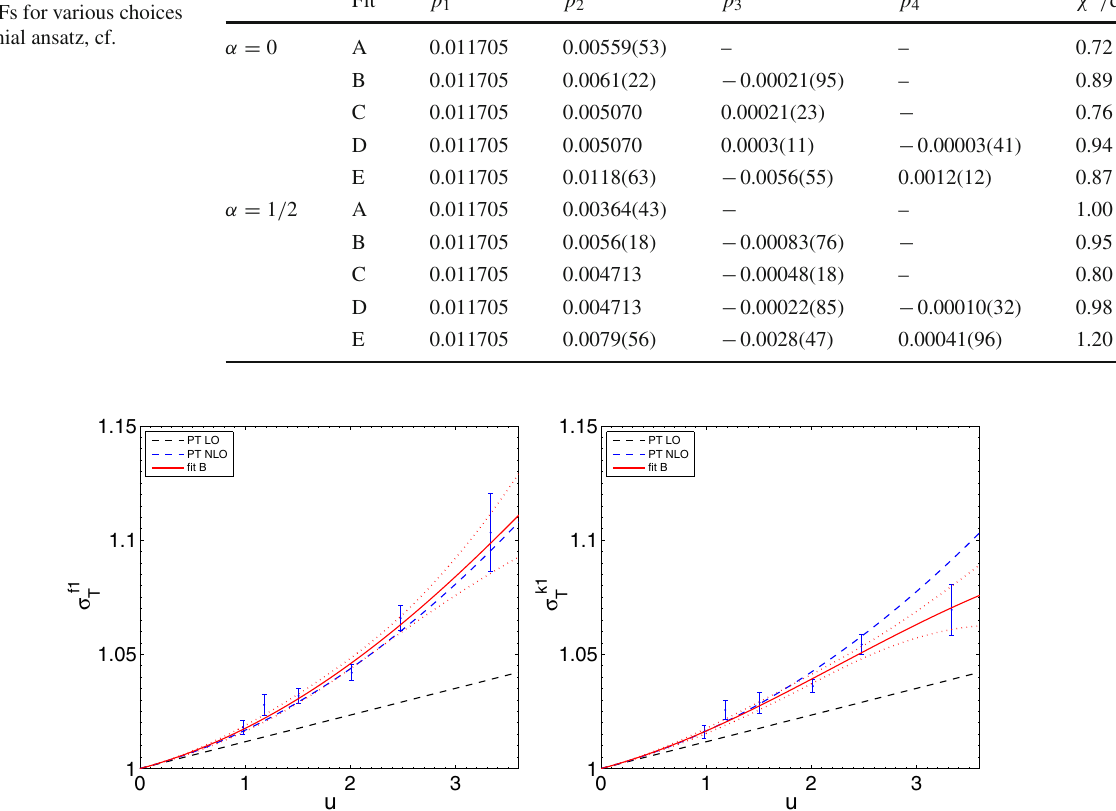
= 2 SSFs for various choices f of polynomial ansatz, cf.